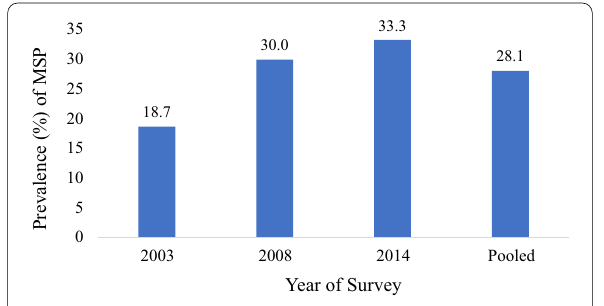
Fig. 2 Prevalence of multiple sexual partners